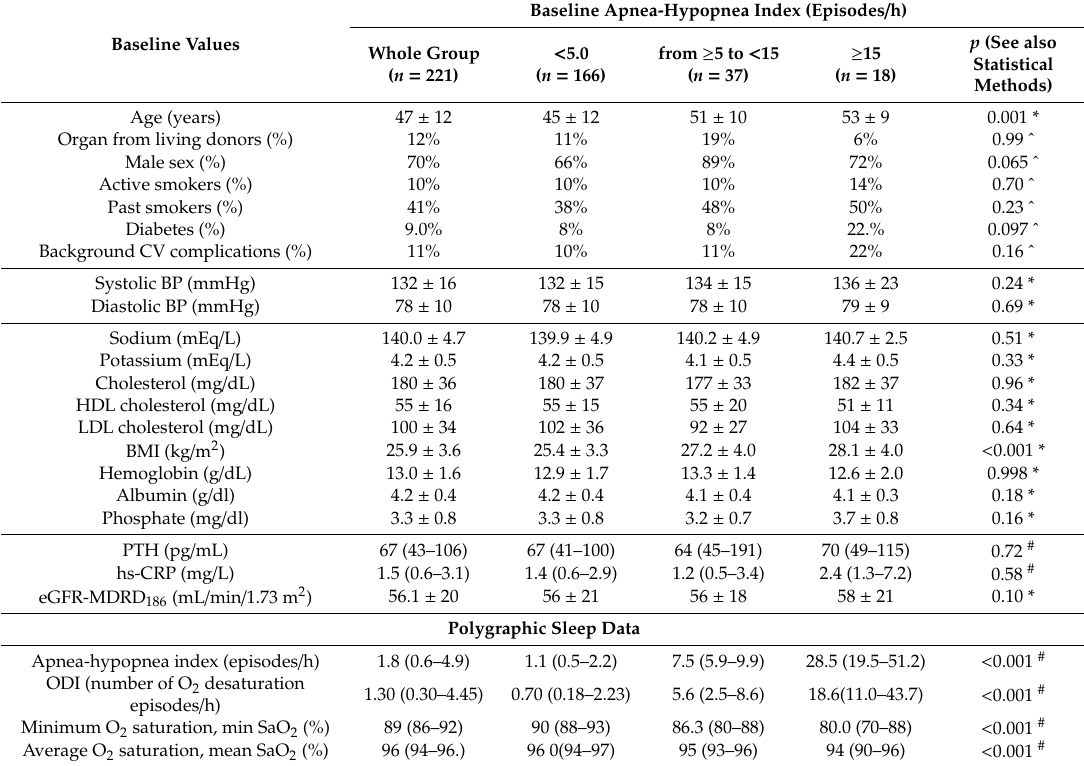
Table 1. Main demographic, clinical and biochemical baseline characteristics of patients grouped